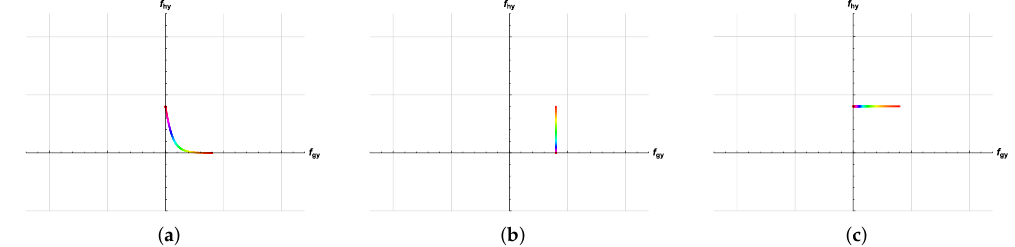
Figure 4. Fault isolability indexes on the fault information manifold. ( a ) F I ( f gy , f hy ) ; ( b ) F I ( f 1 , f gy ) ; ( c ) F I ( f 1 , f hy ) .